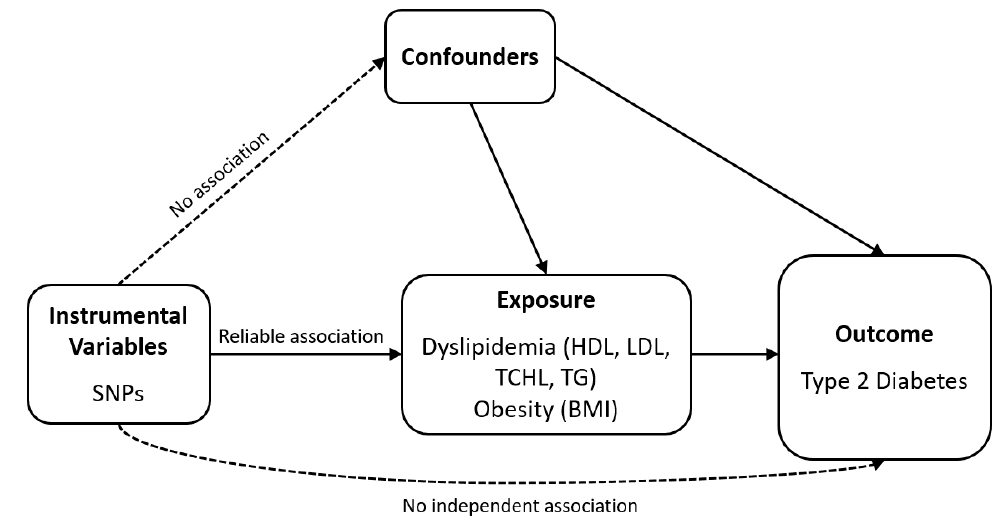
Figure 1. Schematic of the analytical study design. SNP: single-nucleotide polymorphism; HDL: high-density lipoprotein cholesterol; LDL: low-density lipoprotein cholesterol; TCHL: total cholesterol; TG: triglycerides; BMI: body mass index.